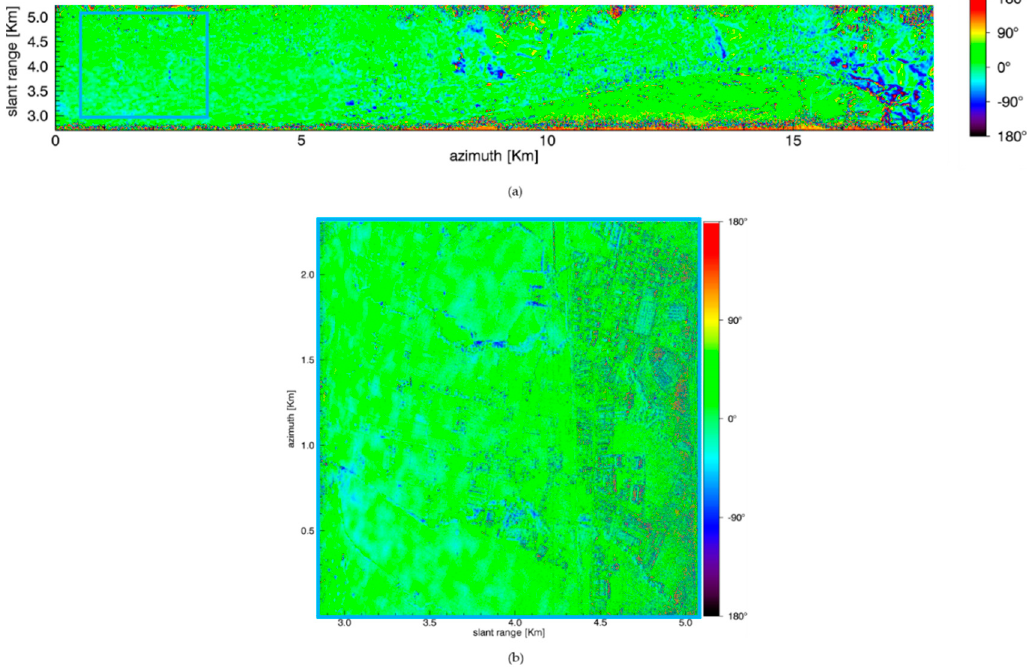
Figure 10. ( a ) Multi-look interferogram obtained from the single-pass data pair focused with the processing parameters of Figure 9a. A 10 range × 10 azimuth pixel averaging window was applied, obtaining 15 m × 16 m pixel spacing. ( b ) Multi-look interferogram obtained from the single-pass data pair focused with the processing parameters of Figure 9b. A 2 range × 10 azimuth pixel averaging window was applied, obtaining 1.5 m × 1.6 m pixel spacing.